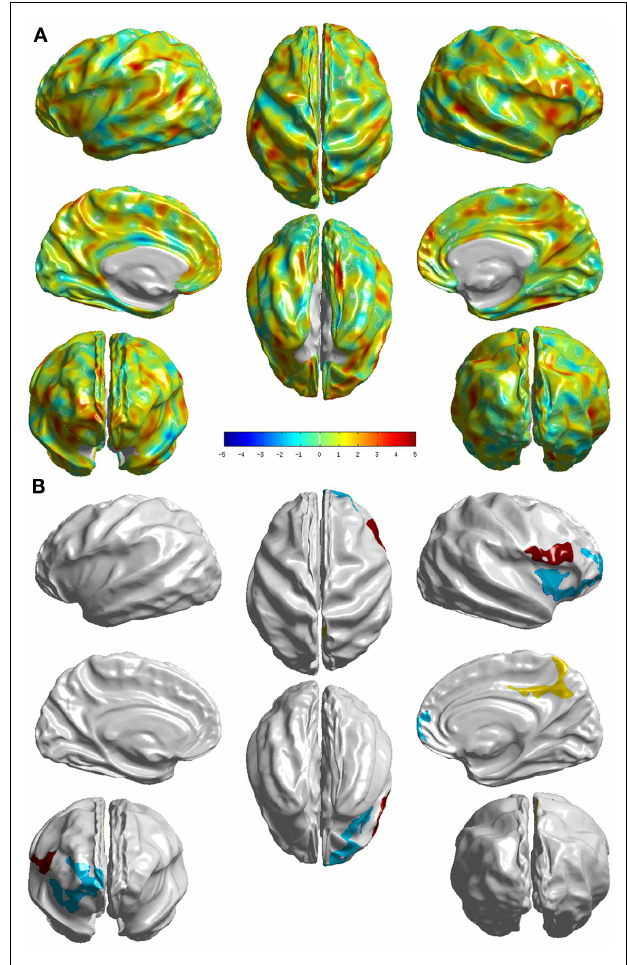
FIGURE 4 |Visualization of the differences between the two groups sd- and md-aMCI . (A) T -statistic values displayed at each vertex (B) the set of clusters, which survived the multiple-comparisons test (cluster-wise significance), each colored differently.These visualizations display areas where md-aMCI is causing significantly differences as compared to